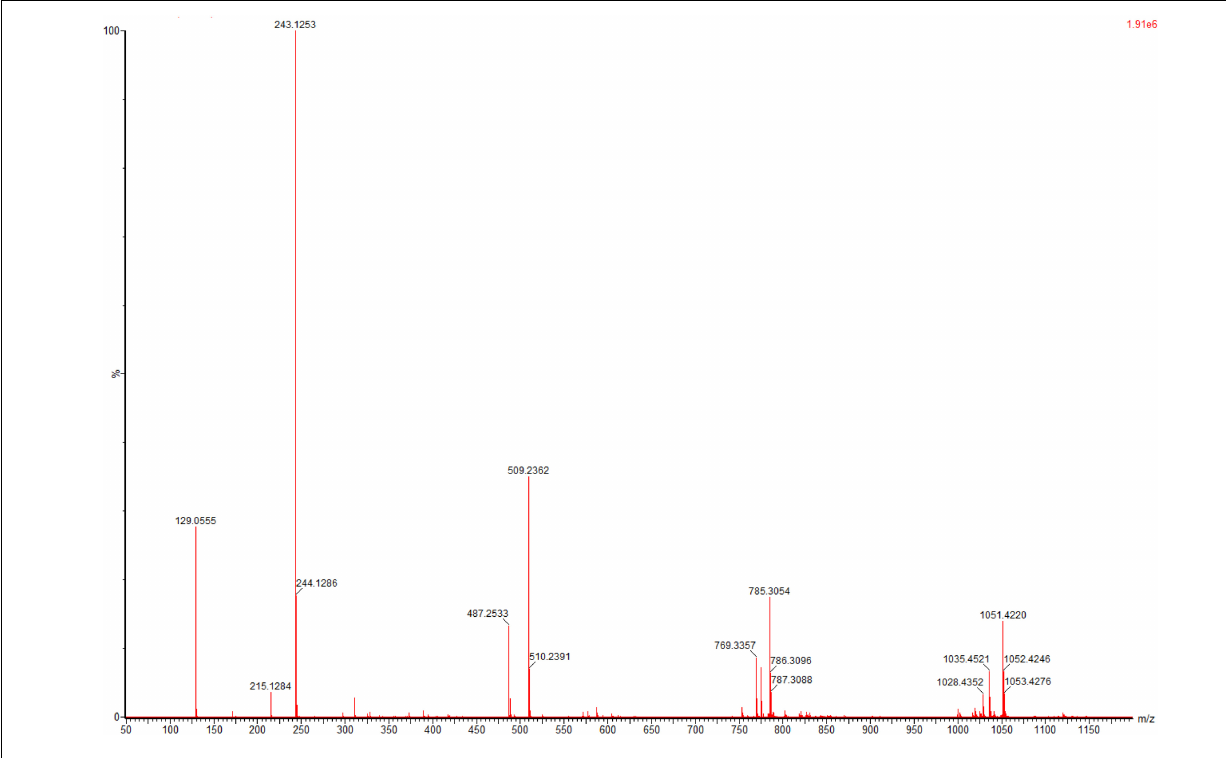
FIGURE 7 | The UPLC-MS analysis of substrates in catalytic products.